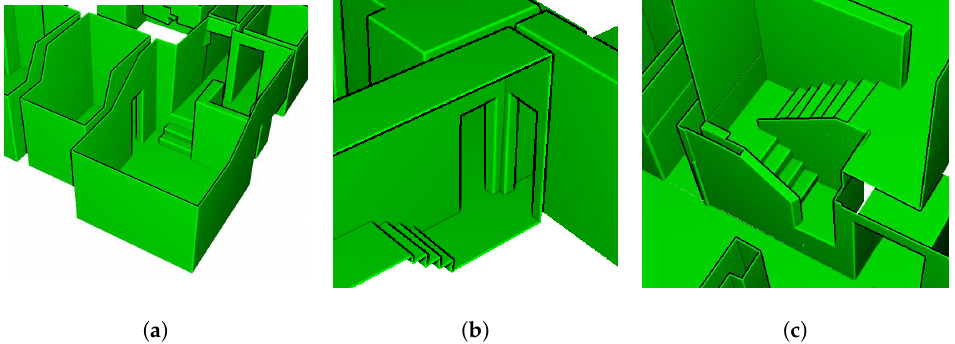
Figure 11. Detailed images of dataset C2. ( a ) inter-floor and three inter-room connections, ( b ) inter- floor and two inter-room connections, and ( c ) inter-floor connection.